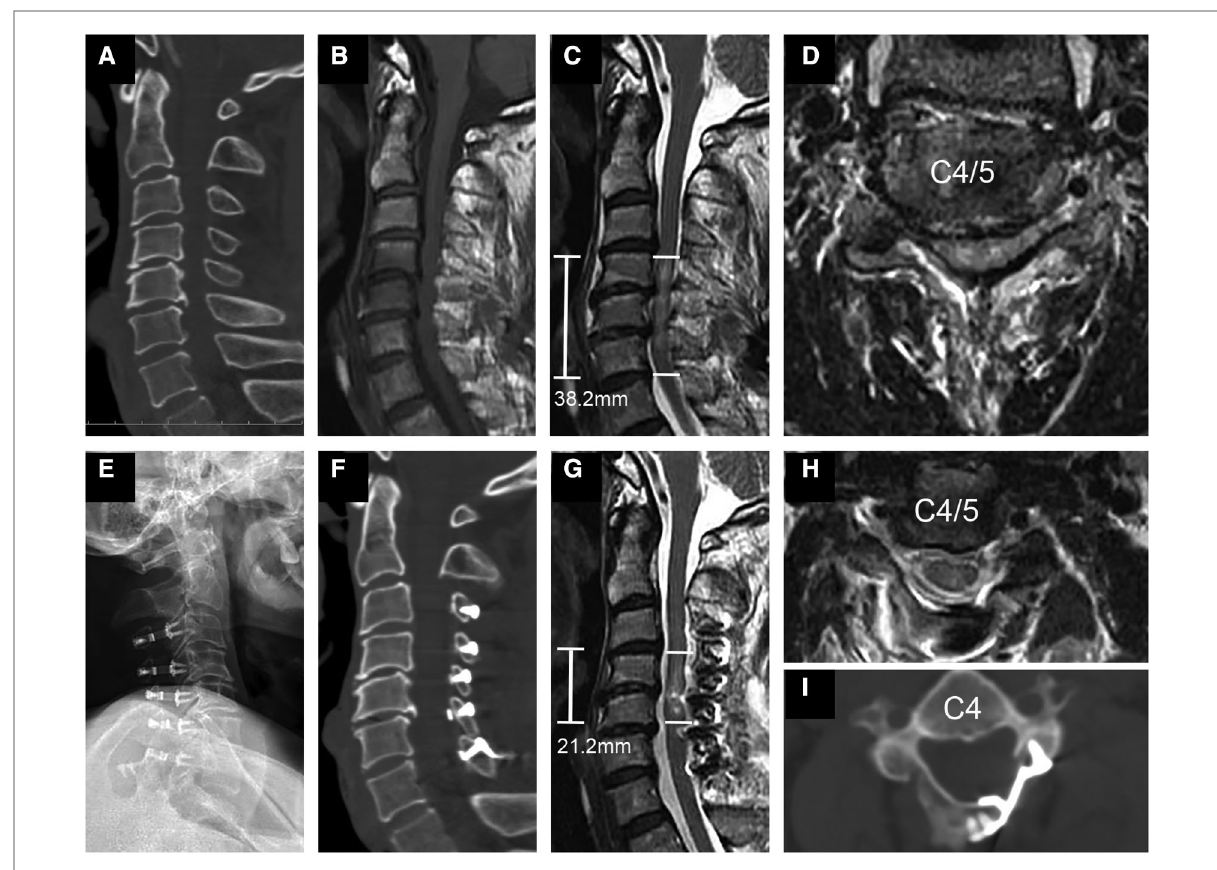
FIGURE 1 Representational preoperative ( A – D ) and postoperative ( E – I ) images of a 58-year-old male patient who sustained a spinal cord injury without fracture or dislocation. His AMS was 18 and AIS grade C. Midsagittal subaxial CT ( A ) indicated cervical spinal stenosis (CSS) from C3 to C6, and MRI ( B ) SCI with an intramedullary lesion length (IMLL) of 38.2 mm. The subarachnoid space (SAS) was absent at C4 and C5 ( C,D ). Laminoplasty of C3 – 7 was performed in this patient 17 h after trauma. Postoperative x-rays ( E ) and CT ( F,I ) showed signi fi cant enlargement of the osseous spinal canal. Postoperative MRI showed an IMLL of 21.2 mm ( G ) and successful decompression ( G,H ) indicated by the presence of an open anterior and posterior SAS 11 days after trauma. One year after injury, the patient recovered from paralysis with an AMS of 100 and AIS grade of